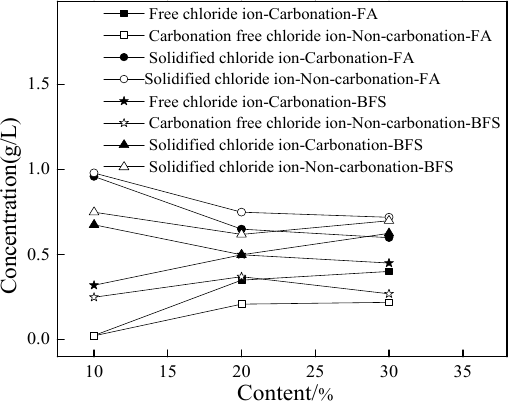
Figure 2. The chlorine concentration of cement paste.